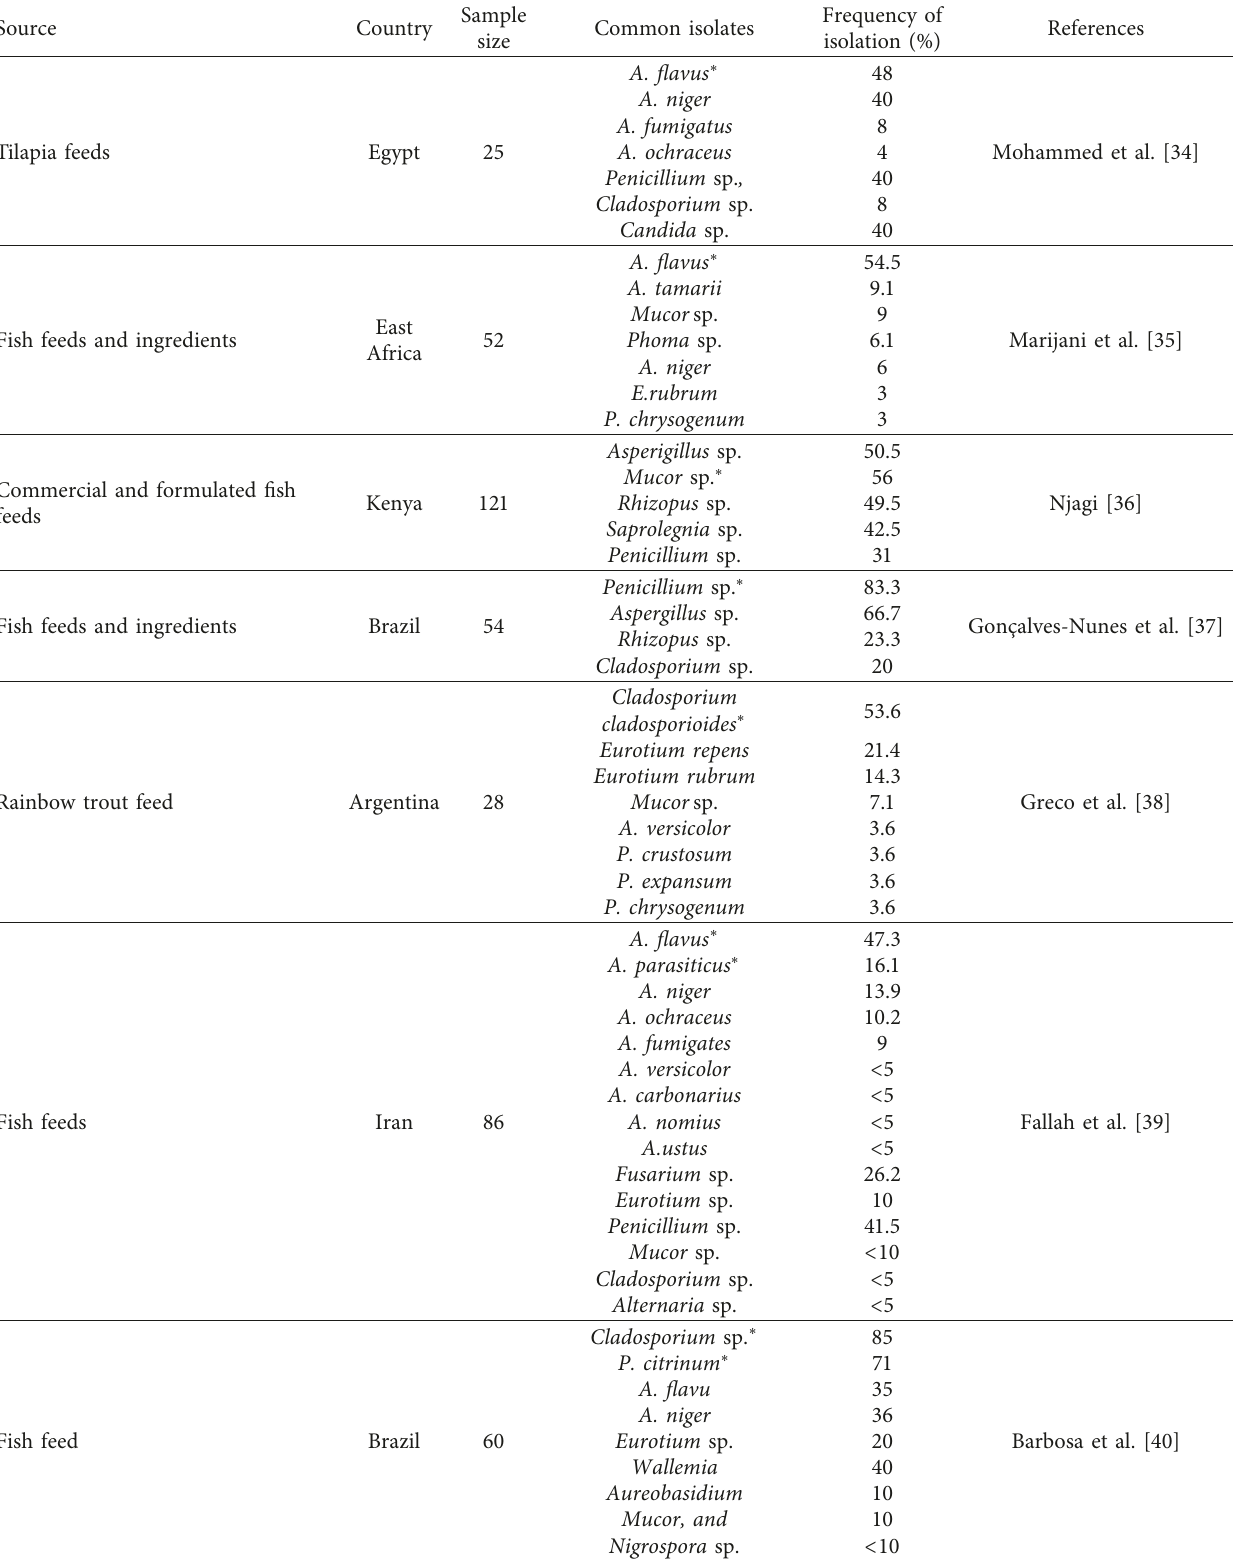
Table 1: Frequently isolated fungi from fish feeds and feed ingredients from previous